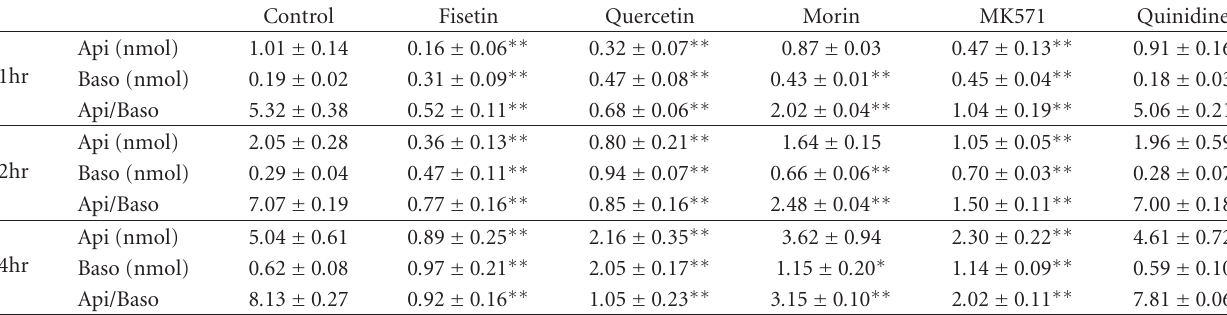
Table 1: The e ff ect of flavonols and transporter inhibitors on the apical and basolateral e ffl ux of N -acetyl 5-aminosalicylic acid in Caco-2 cells. Caco-2 cells grown in Transwells were incubated with 200 μ M 5-ASA for 1, 2, and 4 hours in the presence of flavonols and transporter inhibitors at the concentration of 100 μ M. Api: apical e ffl ux of 5-AcASA, Baso: basolateral e ffl ux of 5-AcASA. Each value represents the mean ± SD of four to five